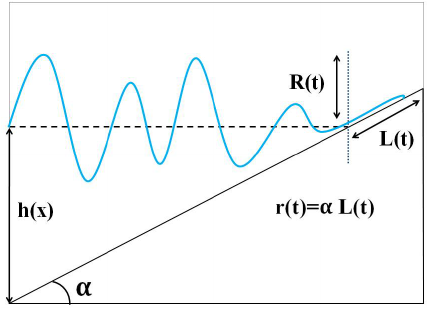
Figure 1. The problem